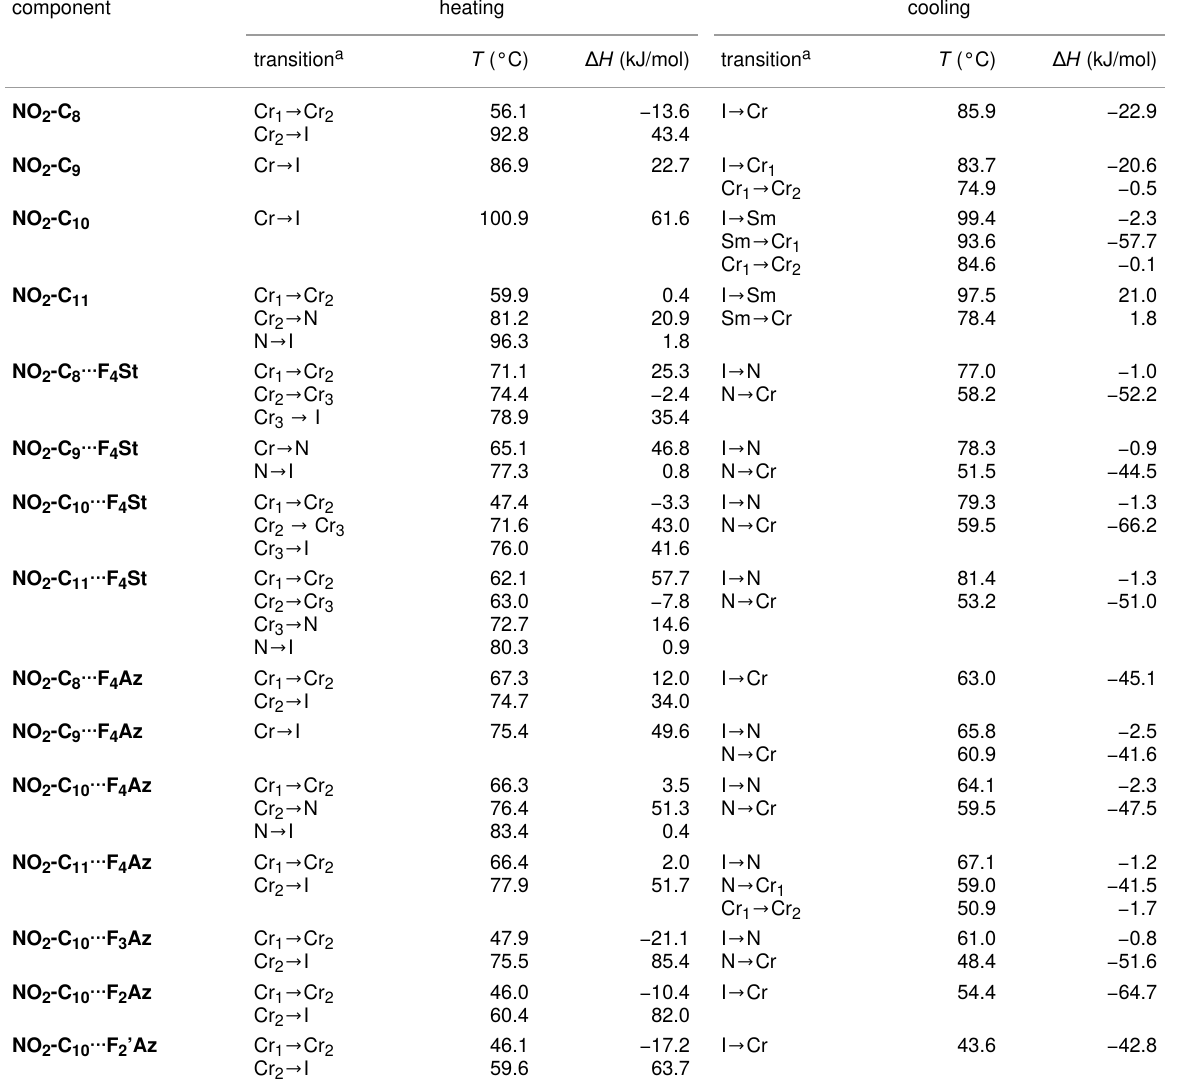
Table 1: Transition enthalpies of all compounds and assemblies upon heating and cooling as determined by DSC (heating/cooling rate of 10 °C/min). component